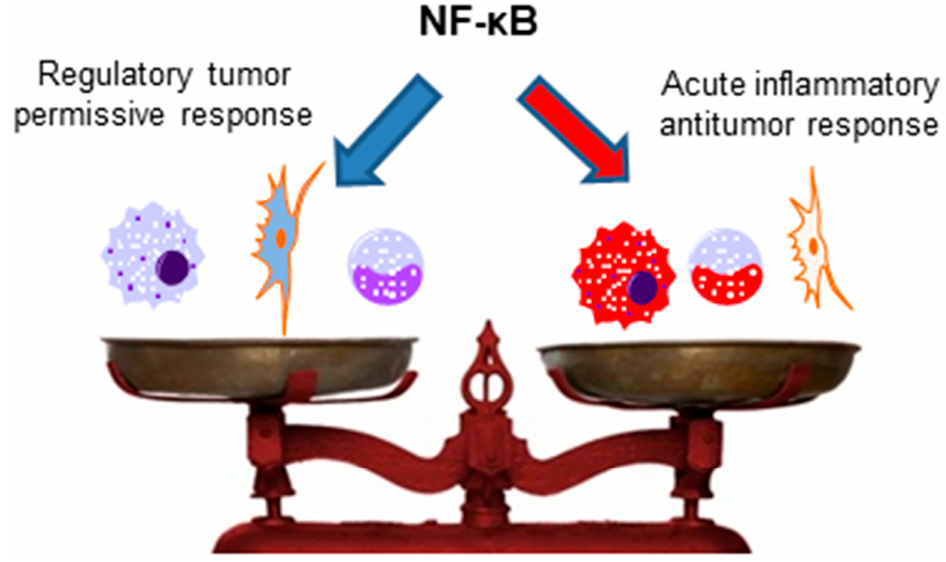
Figure 3. NF- κ B role on tumoral immunity: NF- κ B is important for the function of both pro-inflammatory and regulatory immune cells. As such, NF-kB can have a dichotomic role on tumoral immunity depending on the type of immune cells present in the cancerous tissue. If the majority of infiltrating cells are regulatory cells, like myeloid derived suppressor cells (MDSCs) or T reg, NF-kB expression will be associated to inhibition of antitumor immune response. However, NF-kB can play a crucial role on the anti-tumor immunity driven by infiltrating inflammatory cells, supporting perforin secretion by NK cells and macrophage ability to phagocyte and eliminate tumor cells.